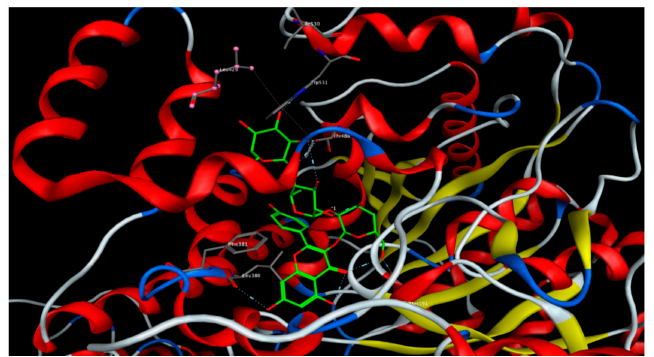
Figure 4. Kaempferol-3- O - β -(2”- O -glucosyl)-rutinoside docked onto the binding site of the fatty acid amide hydrolase (FAAH)